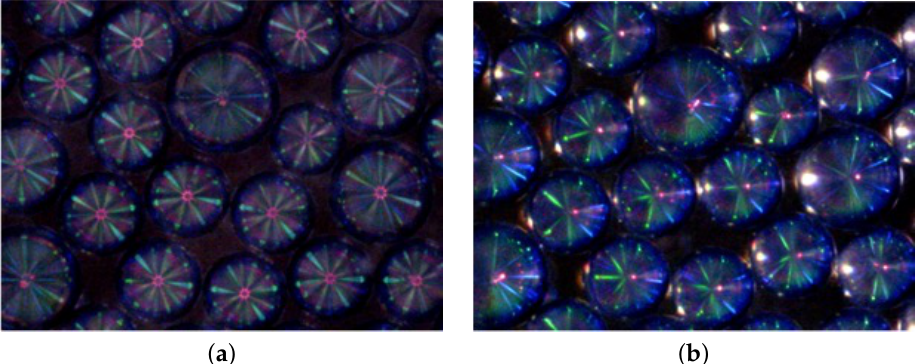
Figure 1. CSR images taken with a non-professional optical microscope at different angles of illumi- nation: ( a ) perpendicular with respect to the sample, ( b ) 45 ◦ with respect to the sample, the response changes